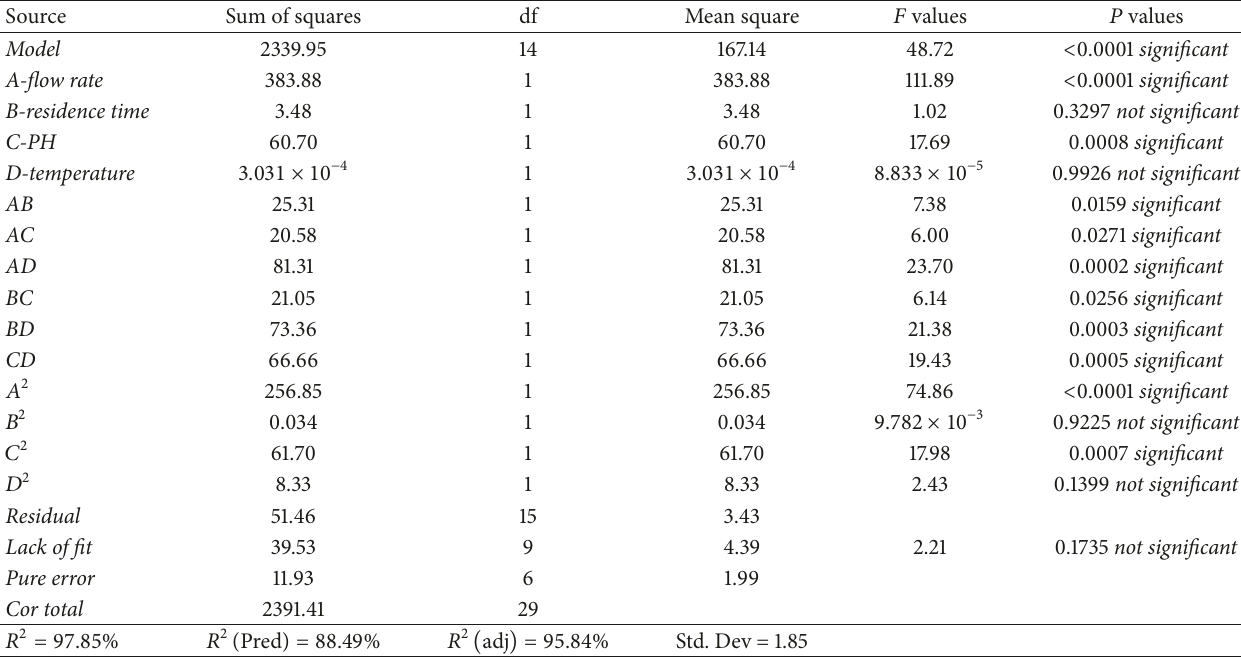
Table 5: ANOVA for response surface reduced quadratic model for MC